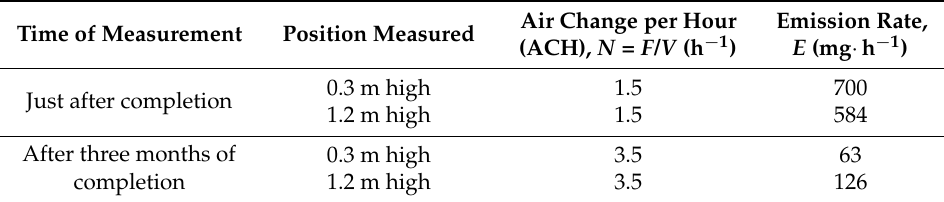
Table 5. Air exchange rates and total volatile organic compound (TVOC) emission rates calculated using Equation (1).